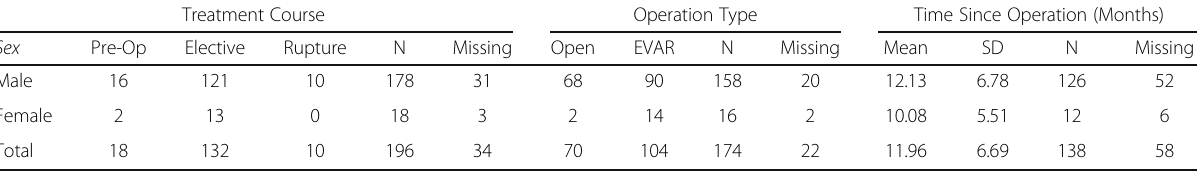
Table 2 Descriptive statistics by gender for treatment course, operation type and time since operation Treatment Course Operation